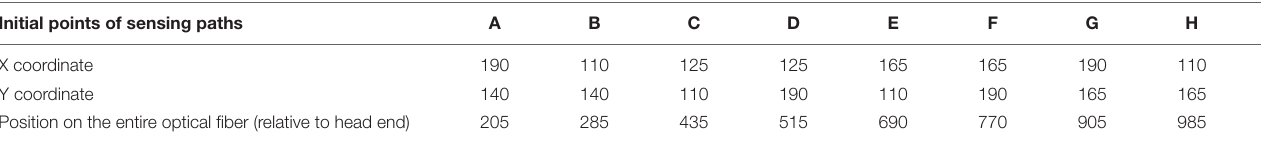
TABLE 2 | The starting points of each optical fiber monitoring path (Unit: mm). Initial points of sensing